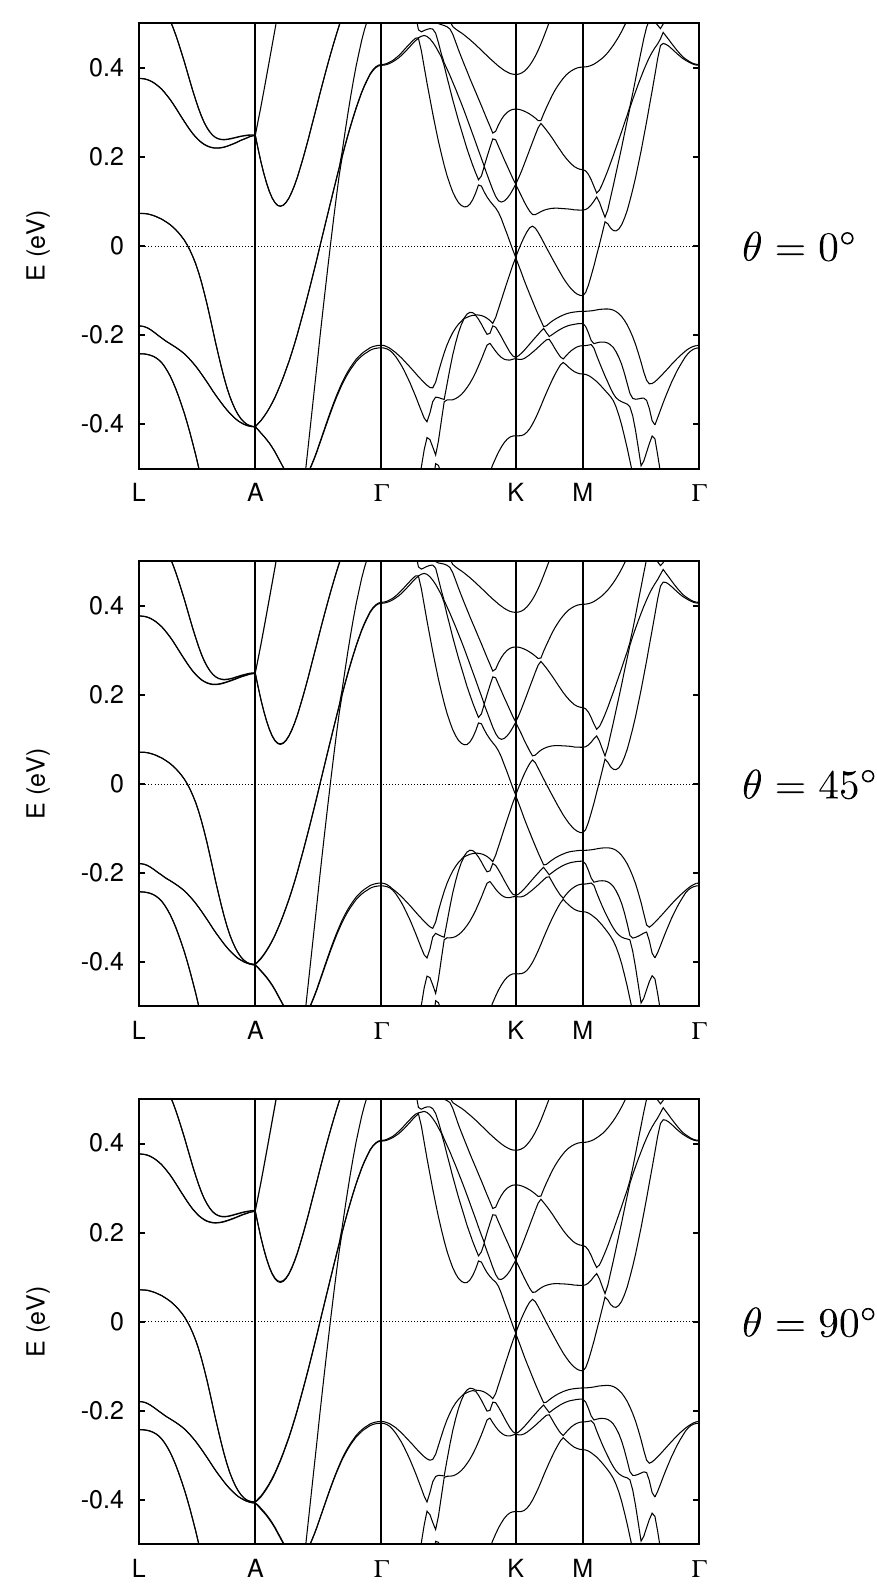
Figure S8: Band structure for three different spin